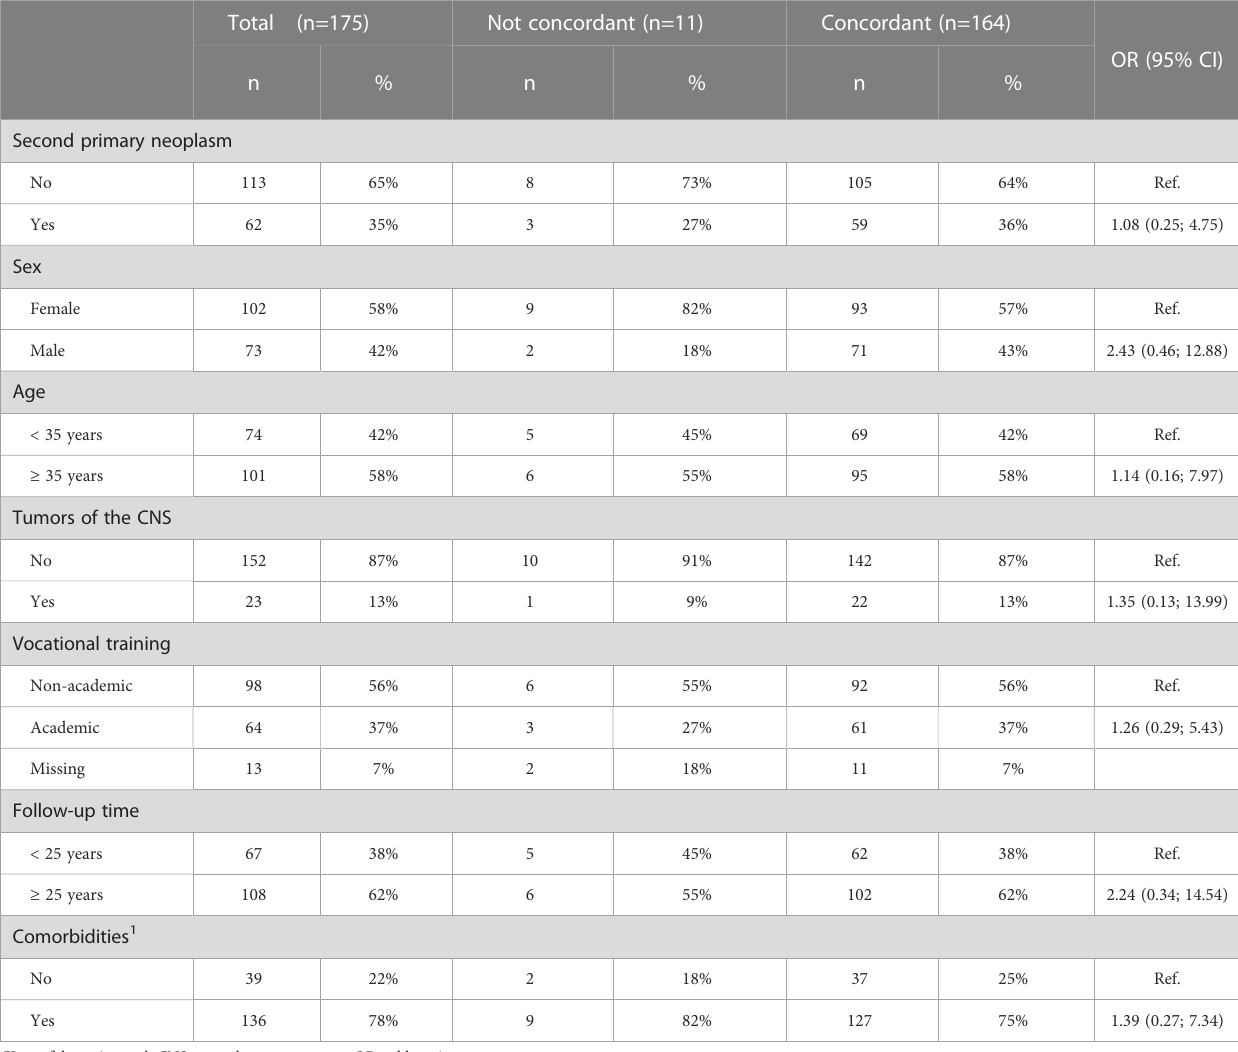
TABLE 4 In fl uencing factors on the correlation between self-reported exposure to radiotherapy and data from medical records of participants from the KiKme